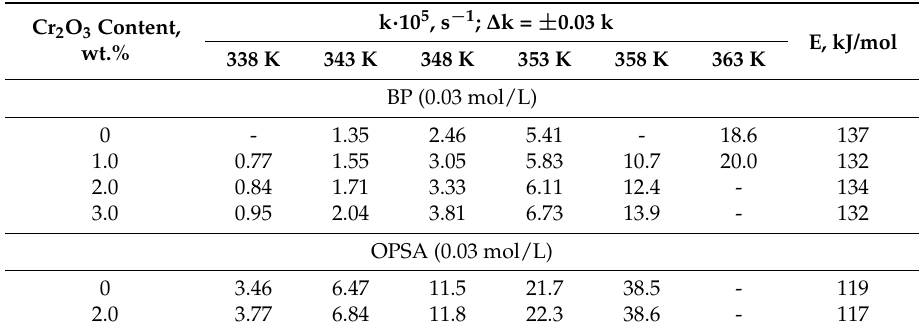
Table 2. The kinetic and activation parameters of the reaction of thermal decomposition of BP and OPSA in the presence of chromium oxide.